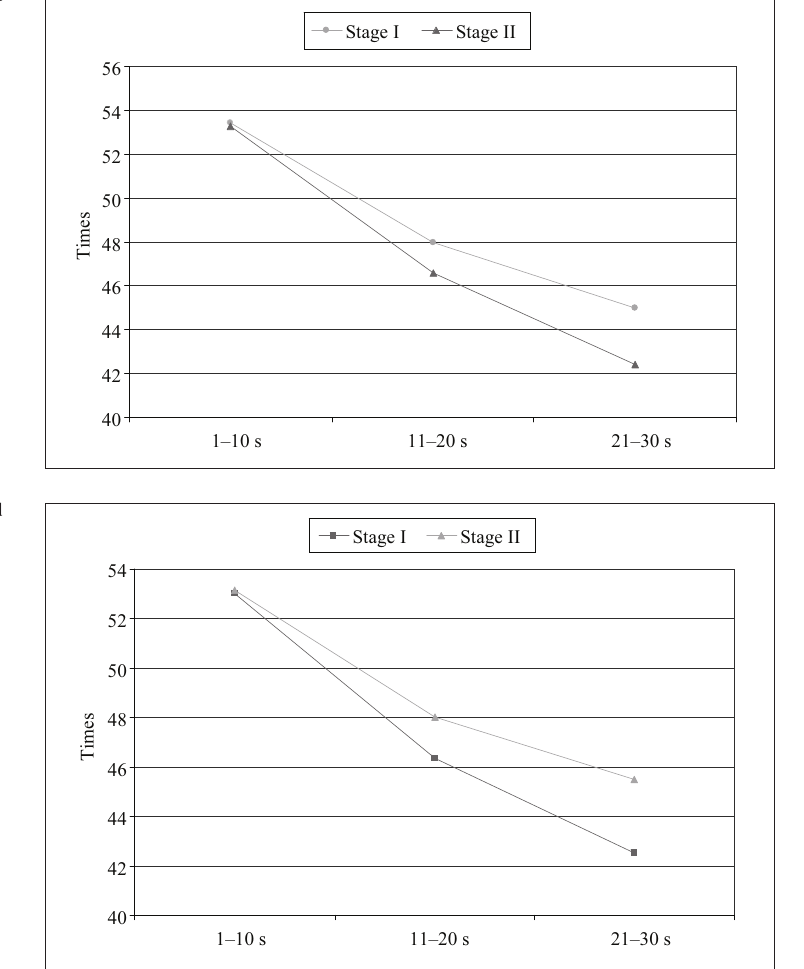
Figure 1. Changes in the frequency of hand movements for girls in 30 s